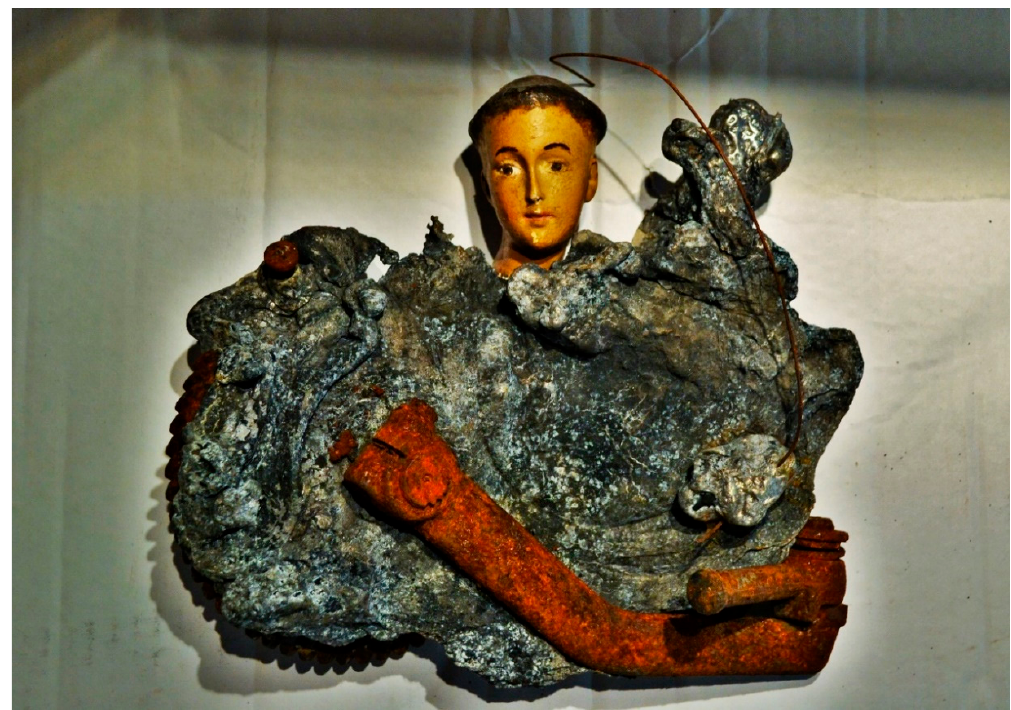
Figure 7. Untitled. Photo by Agricubismo ® .